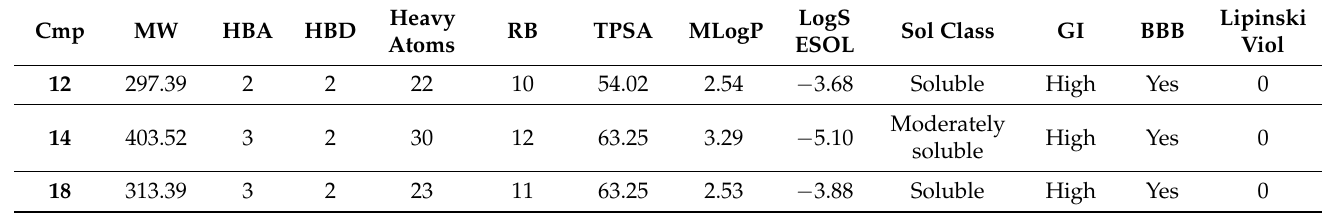
Table 7. Physicochemical properties and ADME parameters: Molecular Weight (MW); number H-bond acceptors (HBA); number H-bond donors (HBD); number of heavy atoms (heavy atoms); number rotatable bonds (RB); topological polar surface area in Å 2 (TPSA); octanol/water partition coefficient (MLogP); water solubility (LogS ESOL); water solubility class (Sol class); gastrointestinal absorption (GI); blood–brain barrier permeation (BBB); number of Lipinski’s rule of five violations (Lipinski